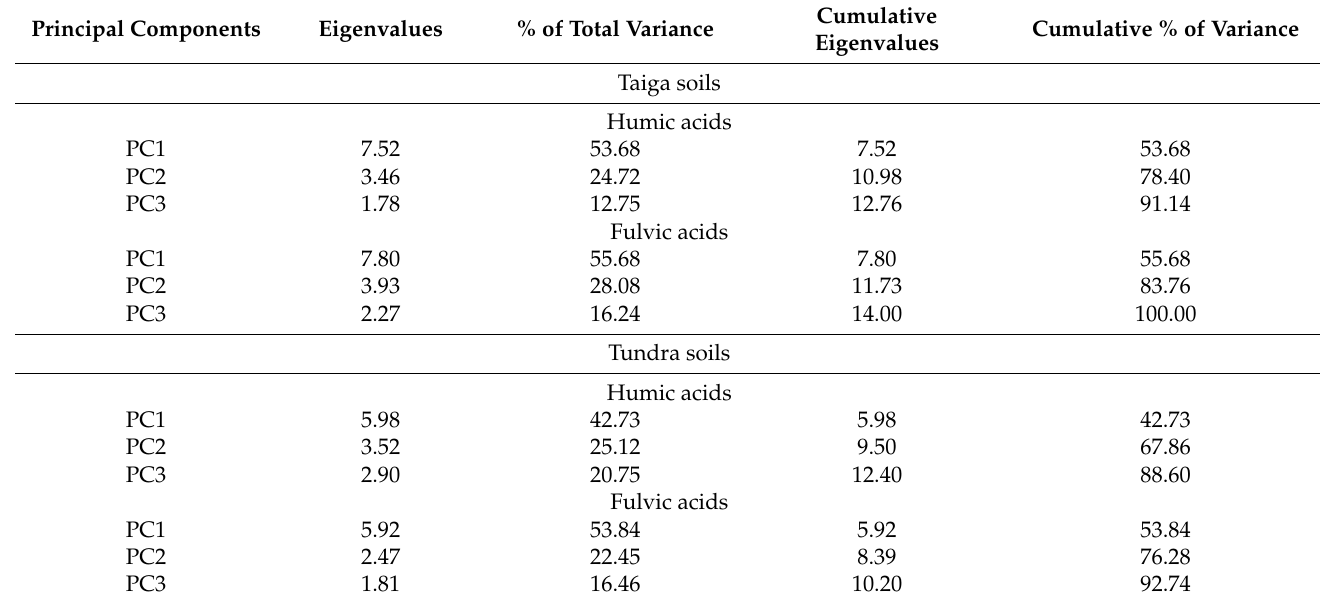
Table 4. Analysis of the principal components for the HS